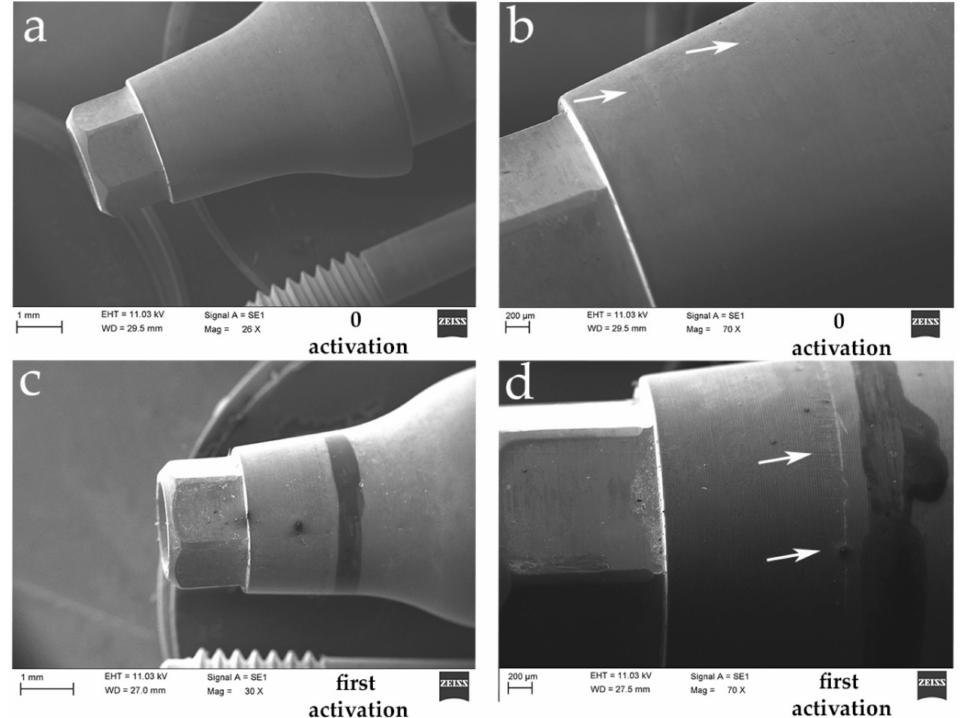
Figure 3. The SEM images show two different magnifications on the abutment surface: ( a ) 26 × and ( b ) 70 × , before activations. No apparent alteration of the titanium is detectable. A wavy pattern is visible as a result of the manufacturing process of the abutment itself. ( c ) 30 × and ( d ) 70 × . The arrows indicate the contact portions between the abutment and the fixture. Vertical streaks and irregularities can be interpreted as points of greatest friction in the